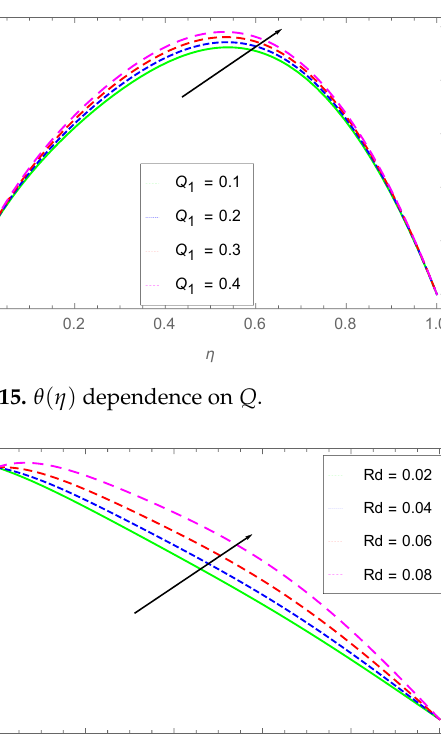
Figure 14. θ ( η ) dependence on Pr .